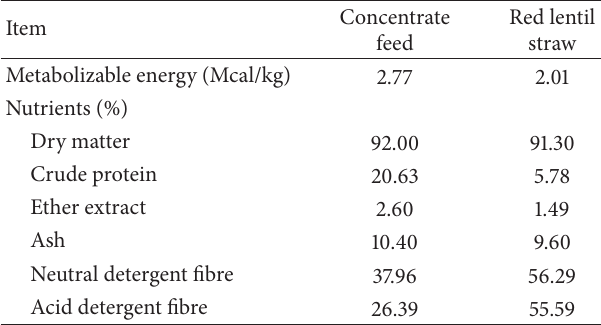
Table 1: Composition of experimental concentrate feed and red lentil